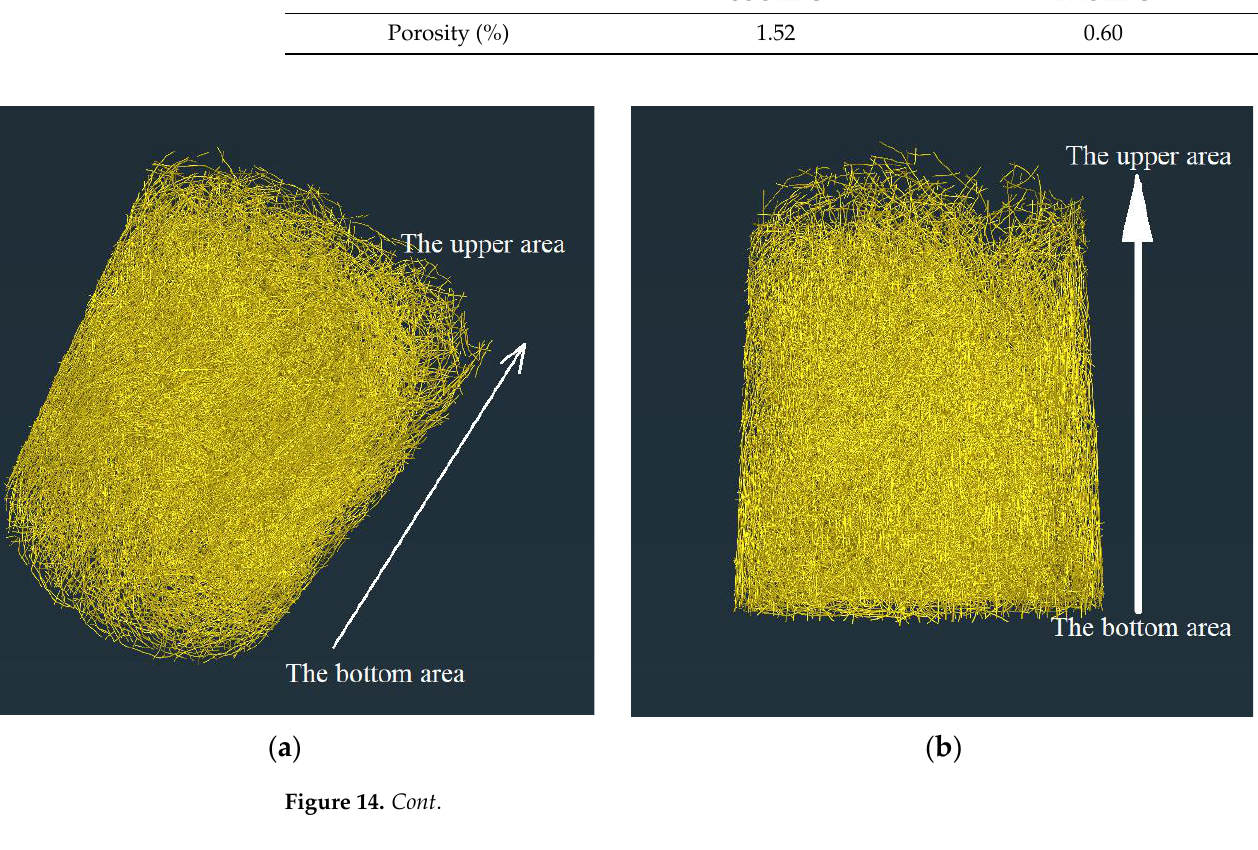
Figure 13. Reconstructed pore structure model of FRUHPC (above 200 µ m): ( a ) Analysis of pore structure characteristics. The І was the whole structure, Ⅱ was the upper area and Ⅲ was the bottom area; ( b ) Top view of pore structure; ( c ) Pore size distribution of FRUHPC. Table 9. Porosity of SSUHPC and FRUHPC obtained by µ X-CT (above 200 µ m). SSUHPC FRUHPC Porosity (%) 1.52 0.60